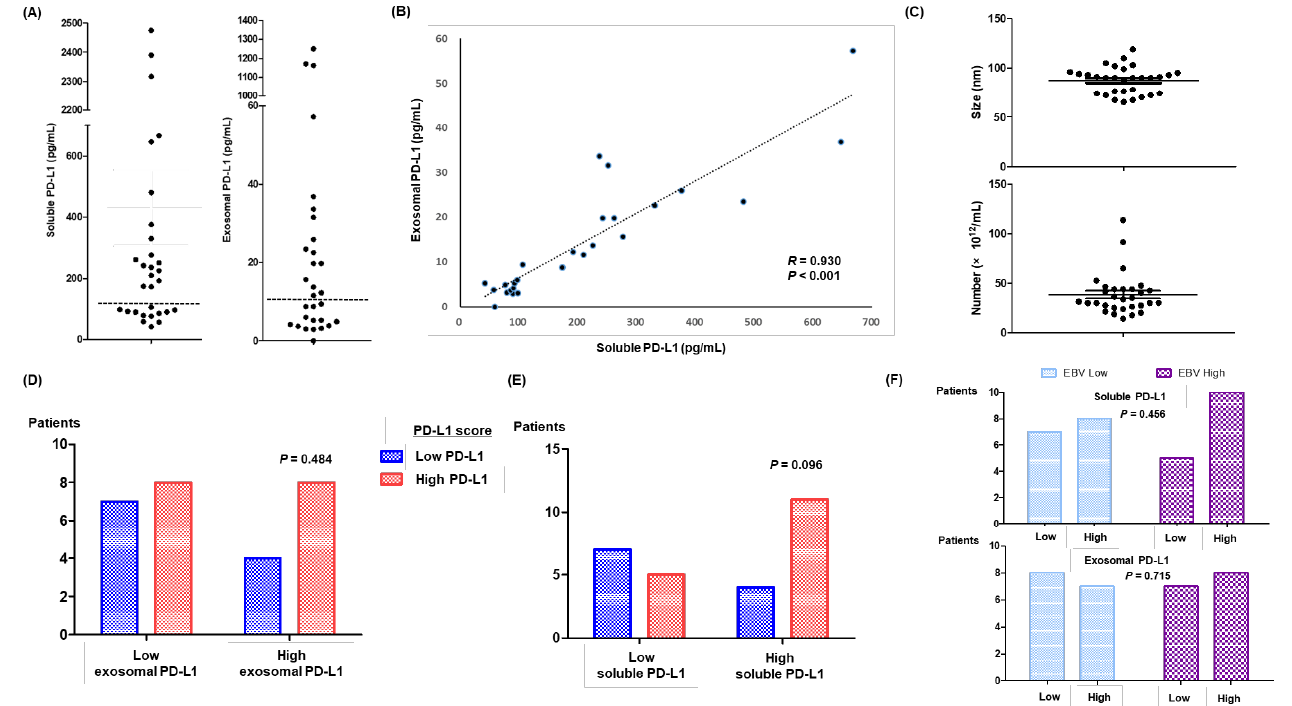
Figure 2. ( A ) Serum levels of soluble and exosomal PD-L1. ( B ) Correlation of exosomal and soluble PD-L1. ( C ) Distribution of the size and number of exosomes. ( D , E ) Comparison of PD-L1 scores in tumor tissue according to high and low exosomal and soluble PD-L1 groups. ( F ) The lack of correlation between high titers of EBV DNA and soluble and exosomal PD-L1.